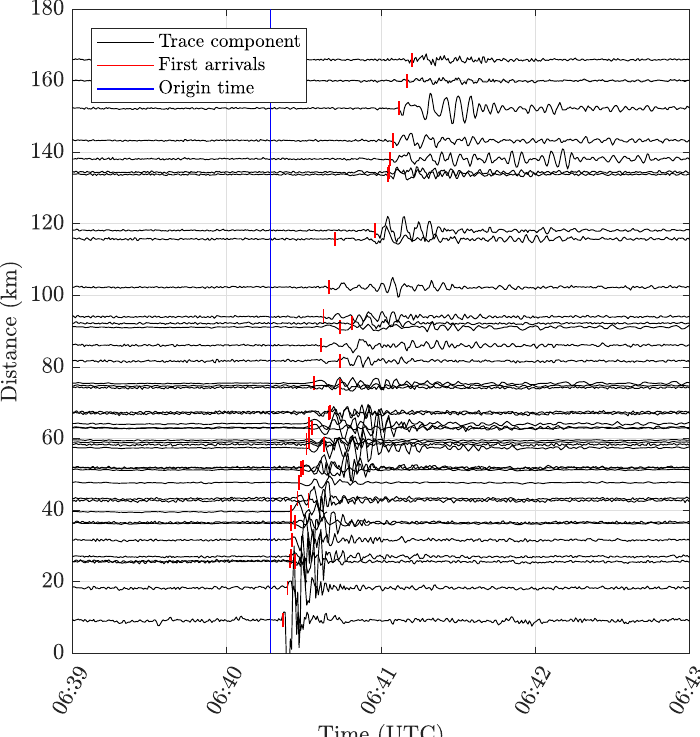
Figure 1. Seismograms of the North velocity component of the Global Navigation Satellite System (GNSS) stations with regard to the station’s epicentral distance, as well as the detected first arrivals from GNSS and the reference origin time. The maximum magnitudes of station velocity lay between 0.5 and 0.01 m/s for the closest and the farthest station,